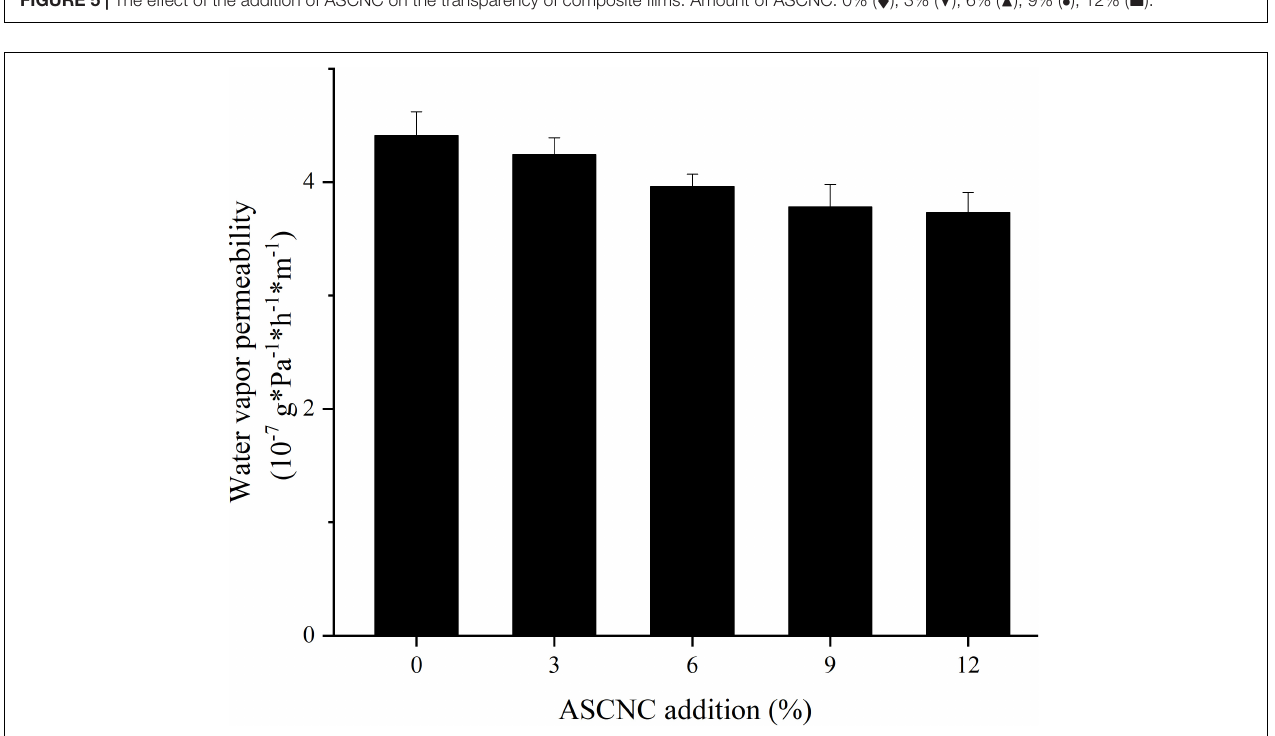
FIGURE 6 | Effect of the amount of ASCNC on the water vapor permeability of film.